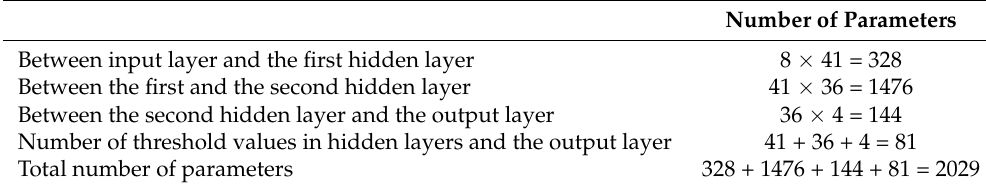
Table 4. Number of parameters optimized by the ABC